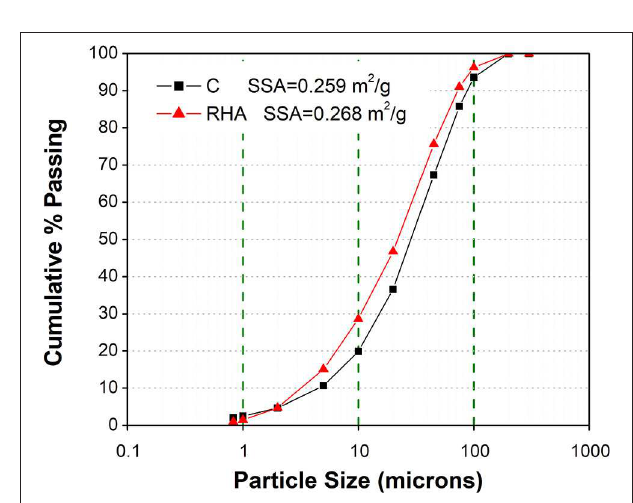
FIGURE 4 | (A) Ball mill used in grinding of RHA, and (B) Sieve shaker used to obtain the RHA finer that 75-micron for using in this study.